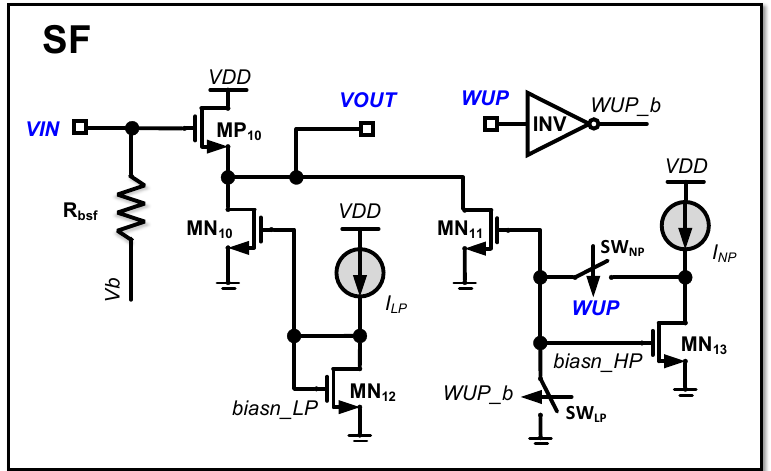
Figure 7. Detailed circuit diagram of the source follower stage.